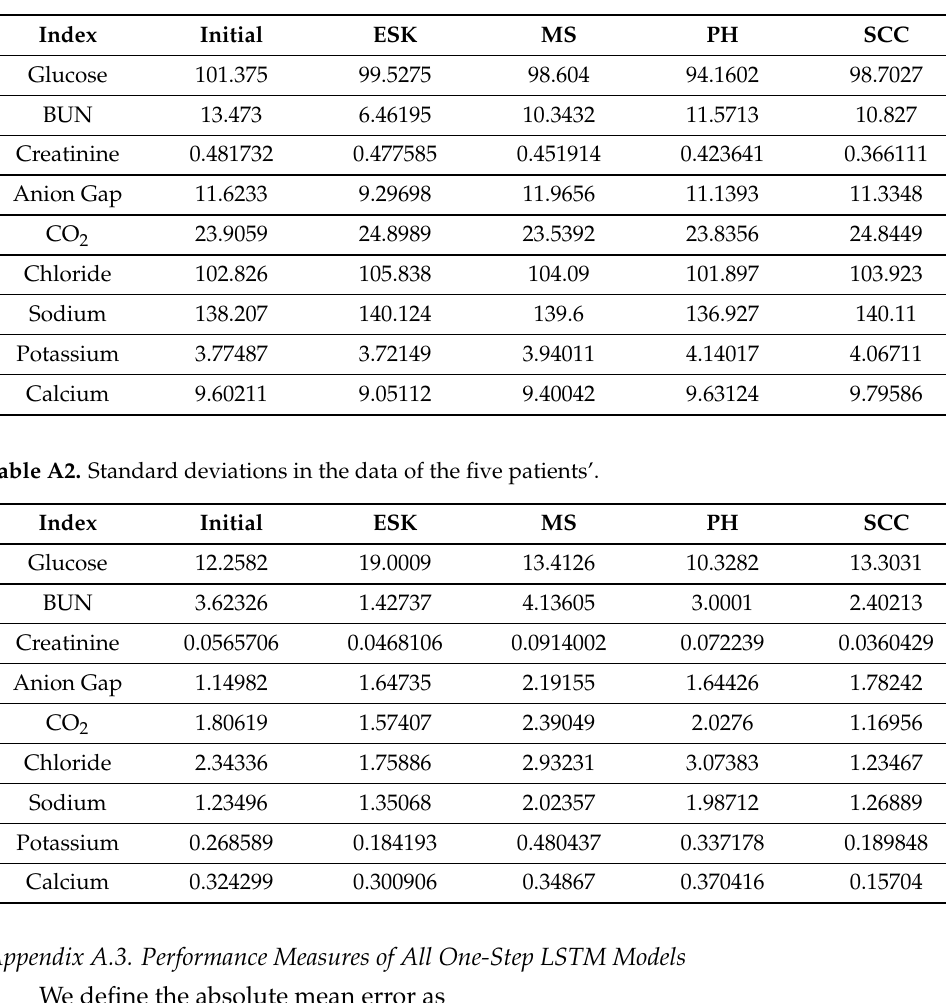
Table A1. Mean values of the indices of in the patients’ data.